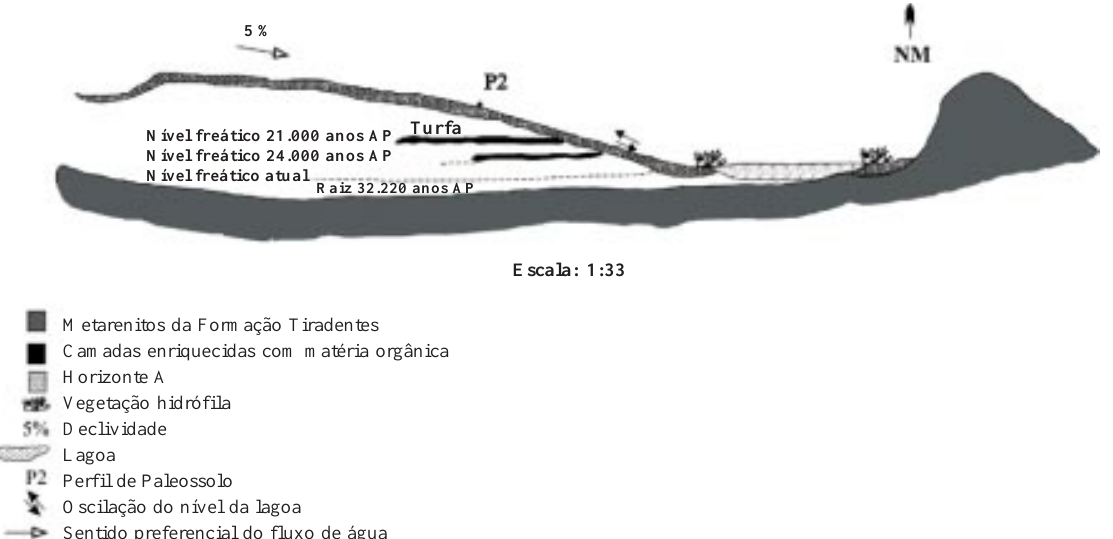
Figura 5. Representação esquemática da gênese das camadas enriquecidas com matéria orgânica no Paleossolo - P2.